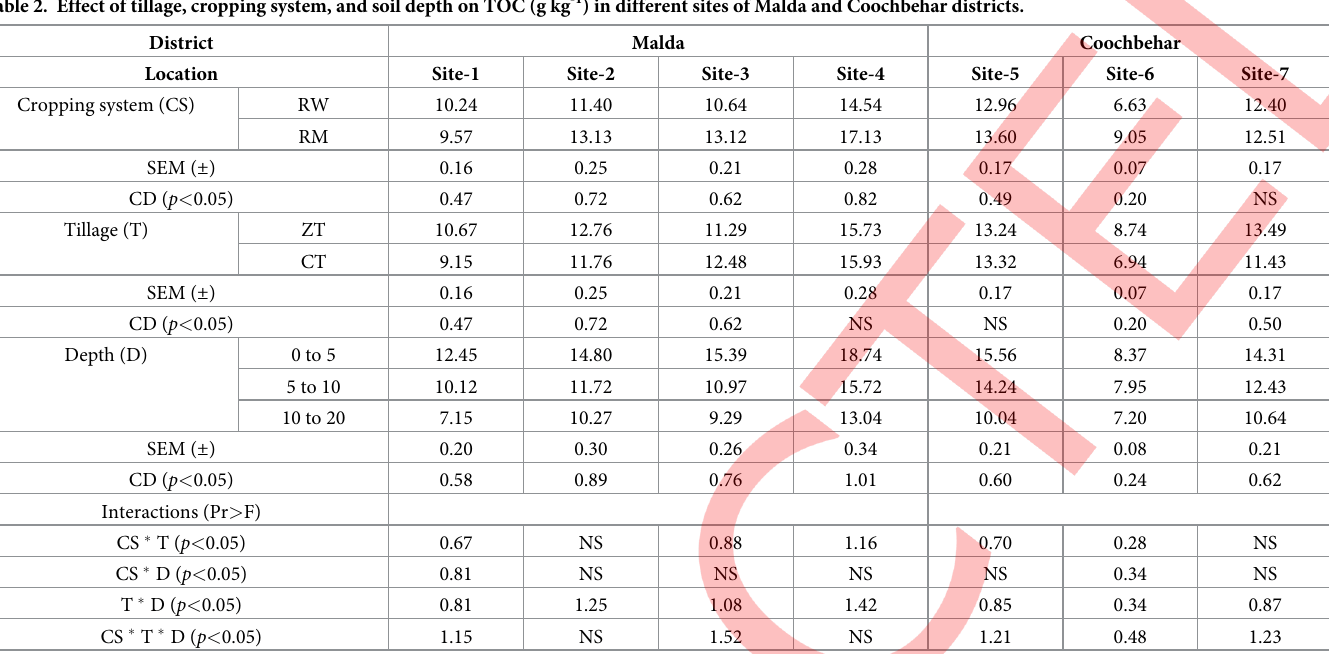
Table 2. Effect of tillage, cropping system, and soil depth on TOC (g kg -1 ) in different sites of Malda and Coochbehar districts. District Malda Coochbehar Location Site-1 Site-2 Cropping system